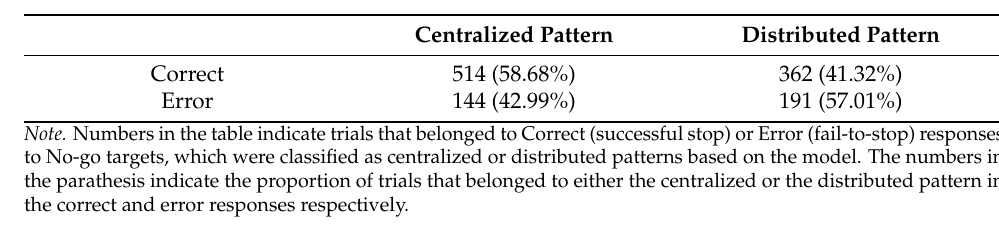
Figure A2. Behavioral performance and eye movement indices in the pre-probe intervals. ( A ) Reaction time (RT). ( B ) Coefficient of variance of RT (RTCV). ( C ) Fixation dispersion. ( D ) Fixation duration. ( E ) Pupil baseline. The number in the bar graph denotes the mean value in that condition. Error bars represent one S.E.M. FA: Focused attention. MW: Mind-wandering. Table A3. Trial numbers across conditions in the objective measure of MW (response to the No-go target).